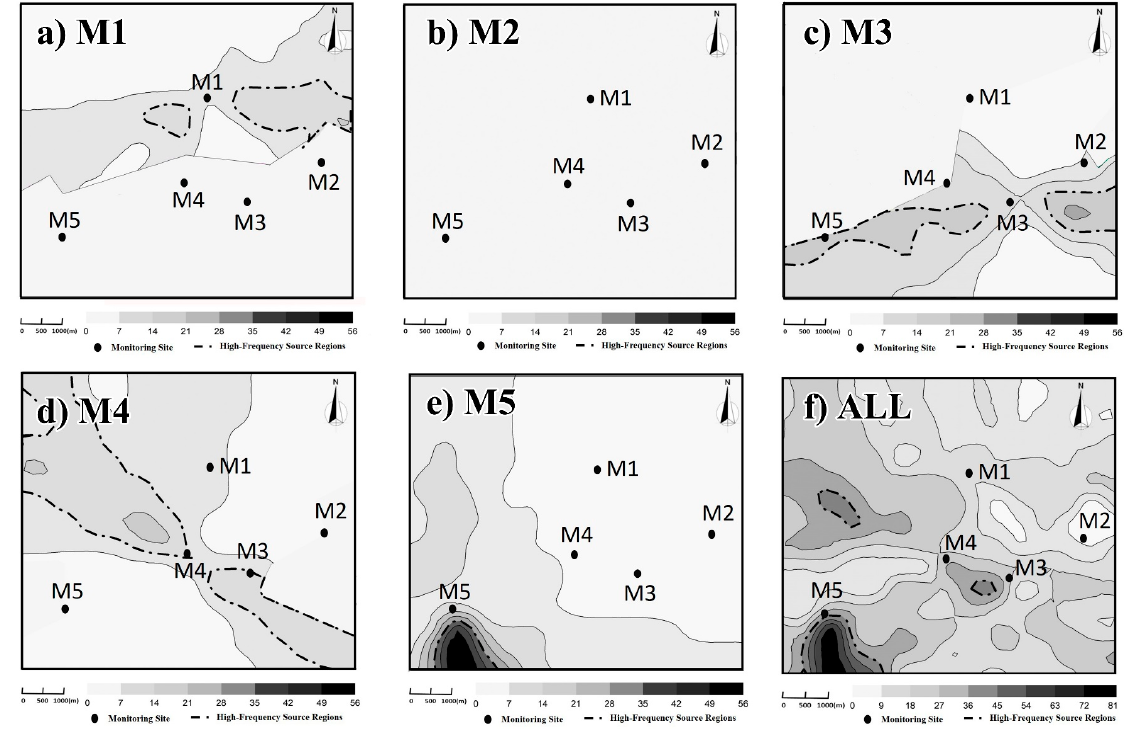
Figure 11. The spatial frequency results of obtained source locations for various monitoring sites: ( a ) spatial frequency results at M1; ( b ) spatial frequency results at M2; ( c ) spatial frequency results at M3; ( d ) spatial frequency results at M4; ( e ) spatial frequency results at M5; ( f ) total frequency results for five monitoring sites. The numbers in the figures were the statistical frequency which represented the times that the position was counted as the suspected source locations.